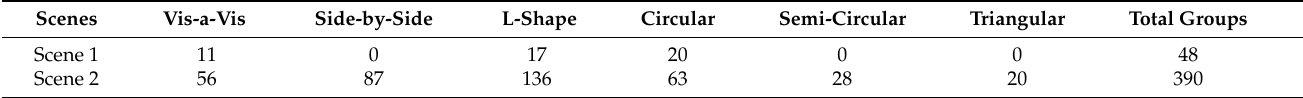
Table 4. F-formations: ground truth information for both the